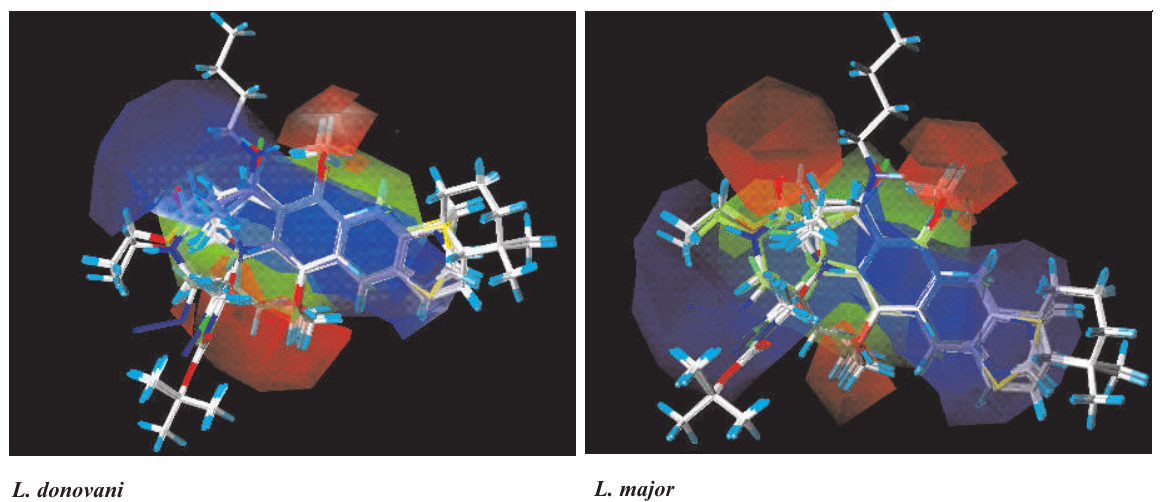
Fig.3. – Favorable and unfavorable bulk for antileishmanial activity found by SIMCA analysis. Green volumes are favorable contribution to steric term. Blue volumes are favorable contribution to activity for electrostatic terms and Red is unfavorable. The analysis was performed for the two